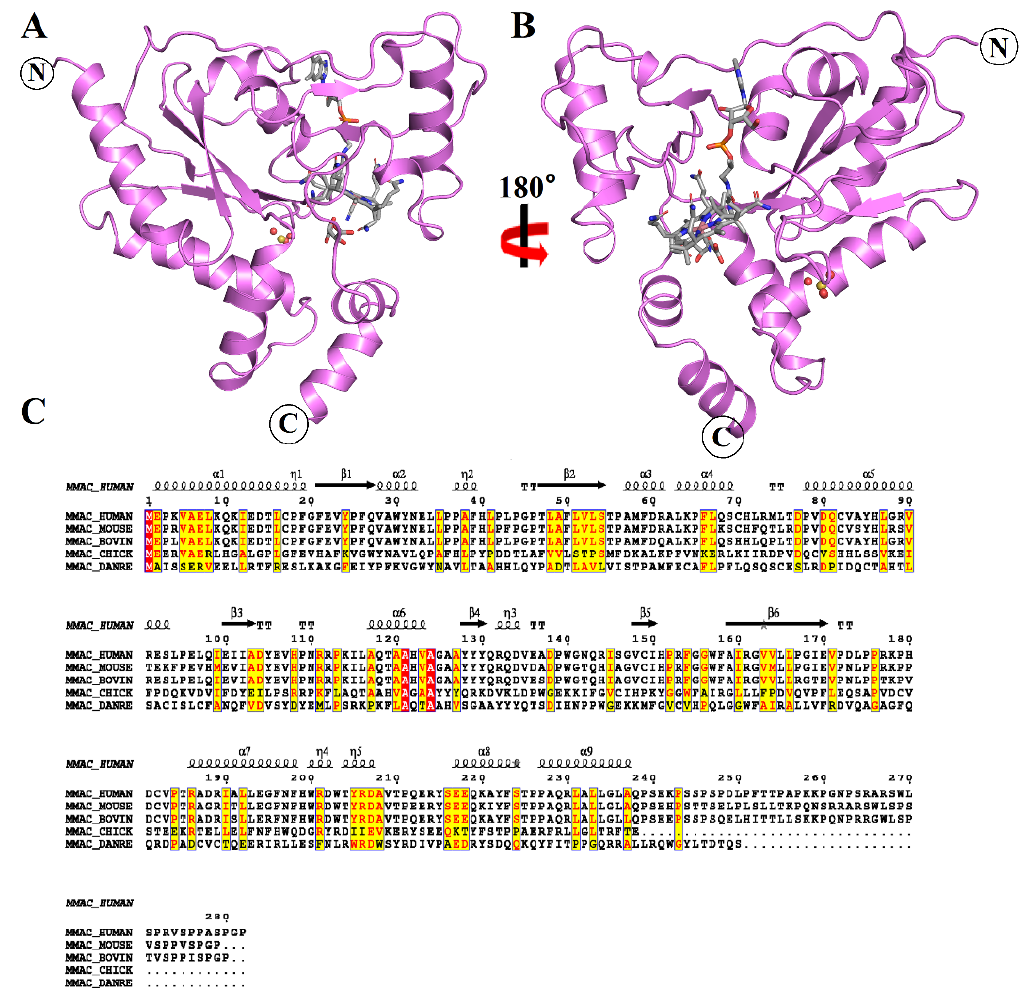
Figure 3. Structure overview of MMACHC with CNCbl: ( A ) crystal structure of the complex of MMACHC and CNCbl (MMACHC shown in violet and cartoon diagram, CNCbl shown in color and sticks); ( B ) the back view of crystal structure of the complex of MMACHC and CNCbl; ( C ) multiple sequence alignment results of MMACHC. The secondary structures of MMACHC are shown above. Red boxes indicate 100% homologous amino acids, while yellow boxes indicate 70% homologous amino acids. The protein names and UniProt codes are MMACHC from human (UniProt: Q9Y4U1); MMACHC from mouse (UniProt: Q9CZD0); MMACHC from bovine (UniProt: Q5E9C8); MMACHC from chick (UniProt: Q5ZL21); MMACHC from rat (UniProt: D4A729).